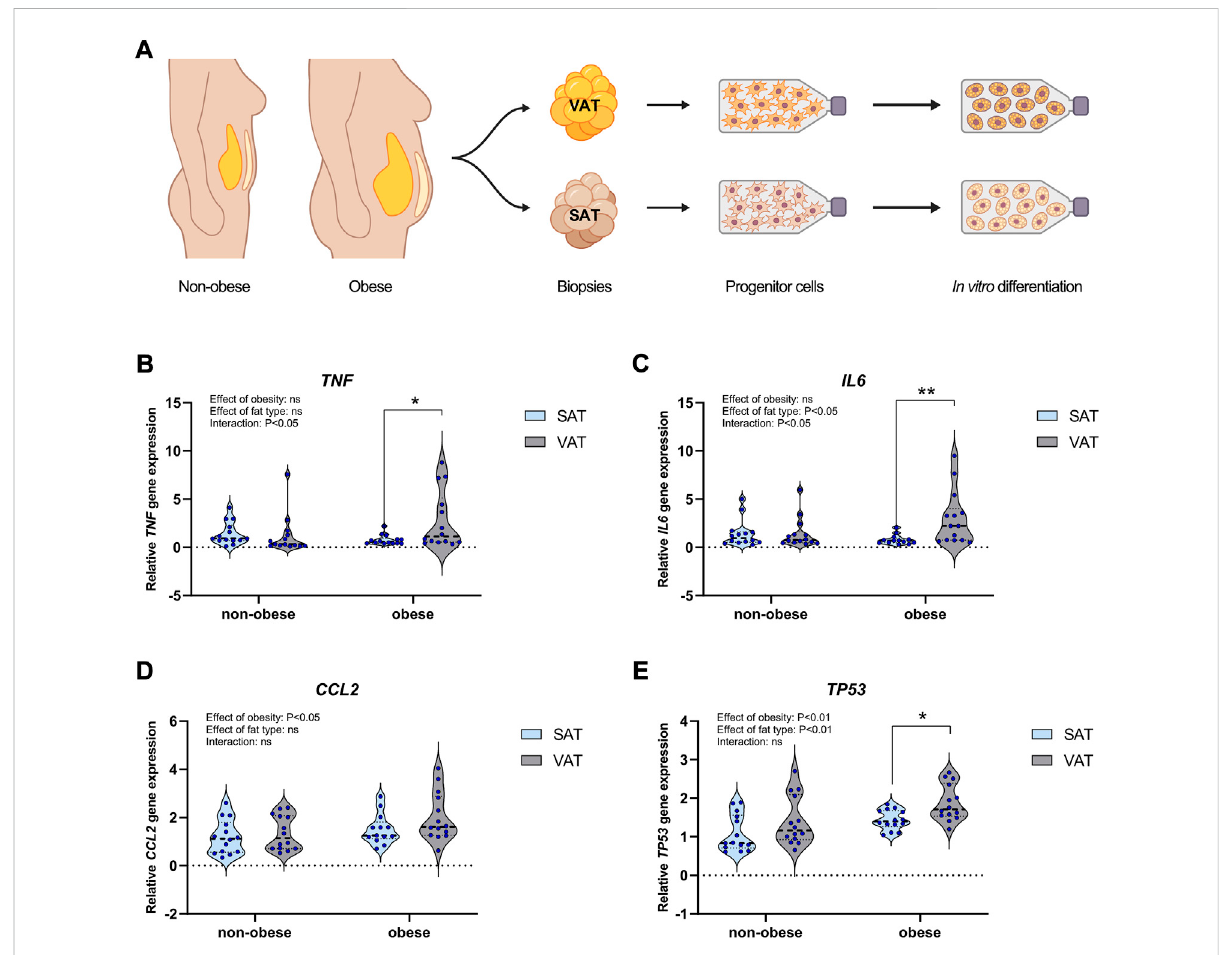
FIGURE 1 Geneexpressionofimmunogenicmarkersinadiposetissueofnon-obesewomenandwomenlivingwith obesity.Adiposetissue biopsies from subcutaneousandvisceraladiposeregionswerecollectedfromgallstonepatients(non-obese, n =14)andgastricsurgerypatients(obese, n =14). (A) Cartoon of adipose tissue depots and isolated cells. (B – E) qPCR analysis of the immunogenic markers TNF , IL6 , CCL2 and TP53 in paired samples of subcutaneous adipose tissue (SAT) and visceral adipose tissue (VAT) obtained from non-obese women and women living with obesity. Differencesbetween groups and adipose depots were assessed using two-way anova with subsequent post-tests. Data are presented as violin plots with thick dotted line showing median and thin dotted lines showing quartiles. Two-way anova assessed difference between groups and depots. Results from signi fi cant post-tests are shown as: * p < 0.05, ** p < 0.01, *** p < 0.001, **** p <